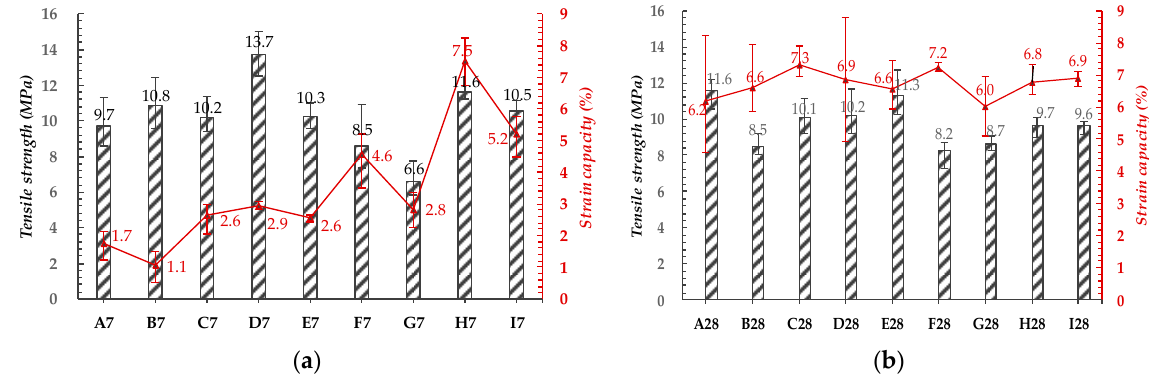
Figure 11. Tensile strength and strain capacity of ( a ) 7 d and ( b ) 28 d cured specimens.